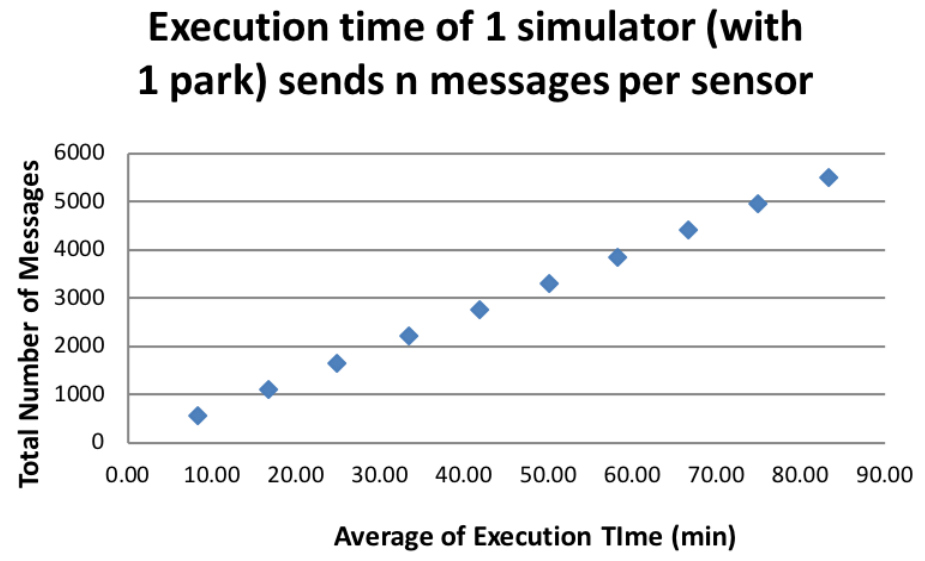
Figure 17. Experiment 1. Slope of the line = (5500 − 550)/(83.29 − 8.47) = 66 messages/minute = 1 messages per second